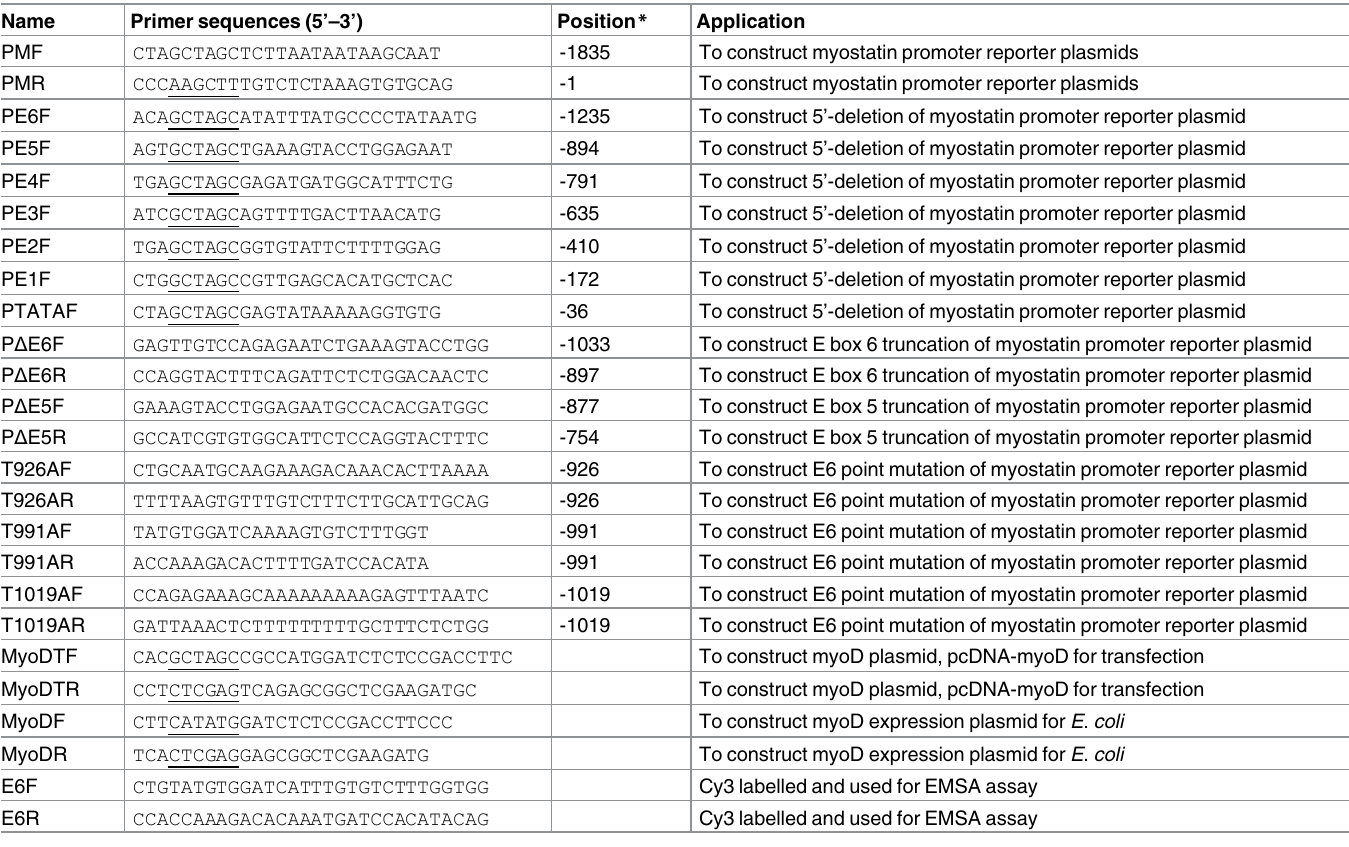
Table 1. Primers used in this